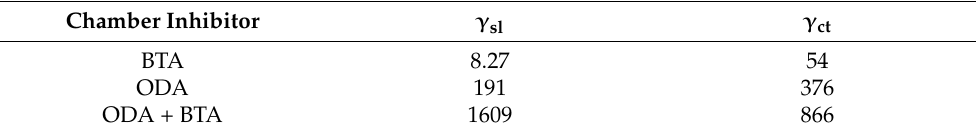
Table 13. Protective effects of the CINs by the blocking and activation mechanisms after brass chamber treatment in different modes. T CT = 120 ◦ C, and τ CT = 60